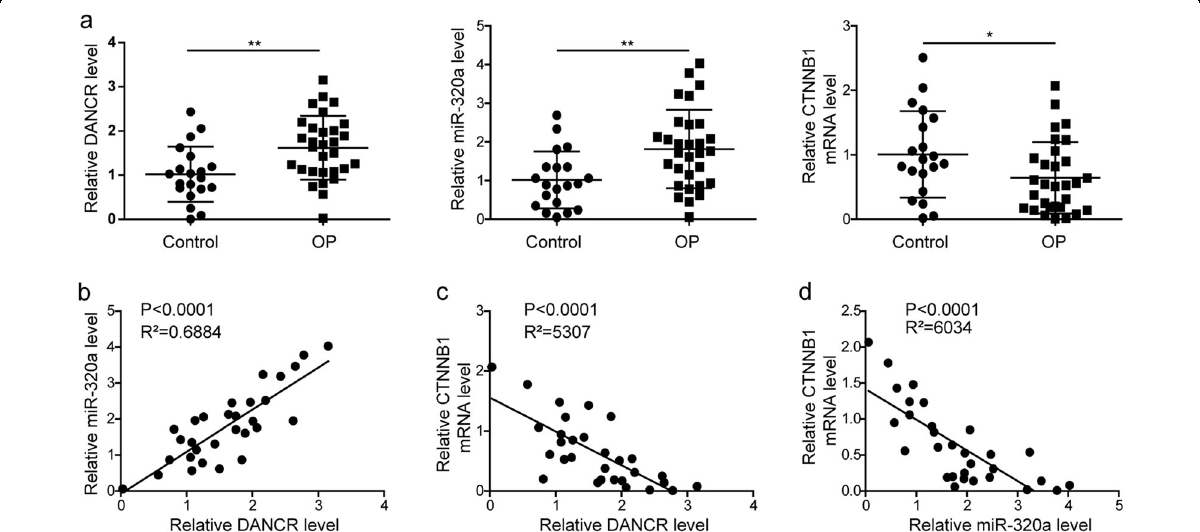
Fig. 1 The differential expression of DANCR, miR-320a, and CTNNB1 in osteoporosis patients. a The expression levels of DANCR, miR-320a, and CTNNB1 were determined by qRT-PCR. b DANCR expression was positively correlated with miR-320a expression in BMSCs of osteoporosis patients ( n = 30). c , d The expression of DANCR ( c ) and miR-320a ( d ) was negatively correlated with CTNNB1 expression in BMSCs of osteoporosis patients ( n = 30). All experiments were conducted independently at least three times. * P < 0.05 and ** P <